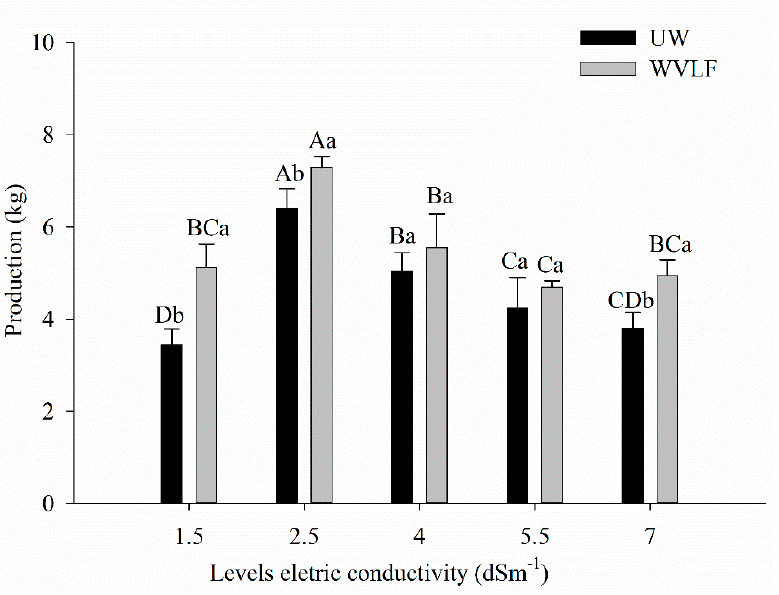
Figure 4. Tomato production in response to different levels of fertigation and irrigation management with electromagnetically treated (WVLF) and untreated water (UW). Means followed by the same letter (lowercase compares the type of water and uppercase compares the salinity doses) do not differ statistically ( p < 0.05) according to the Tukey test. Error bars indicate the standard deviation of the mean of four replicates ( n = 4).